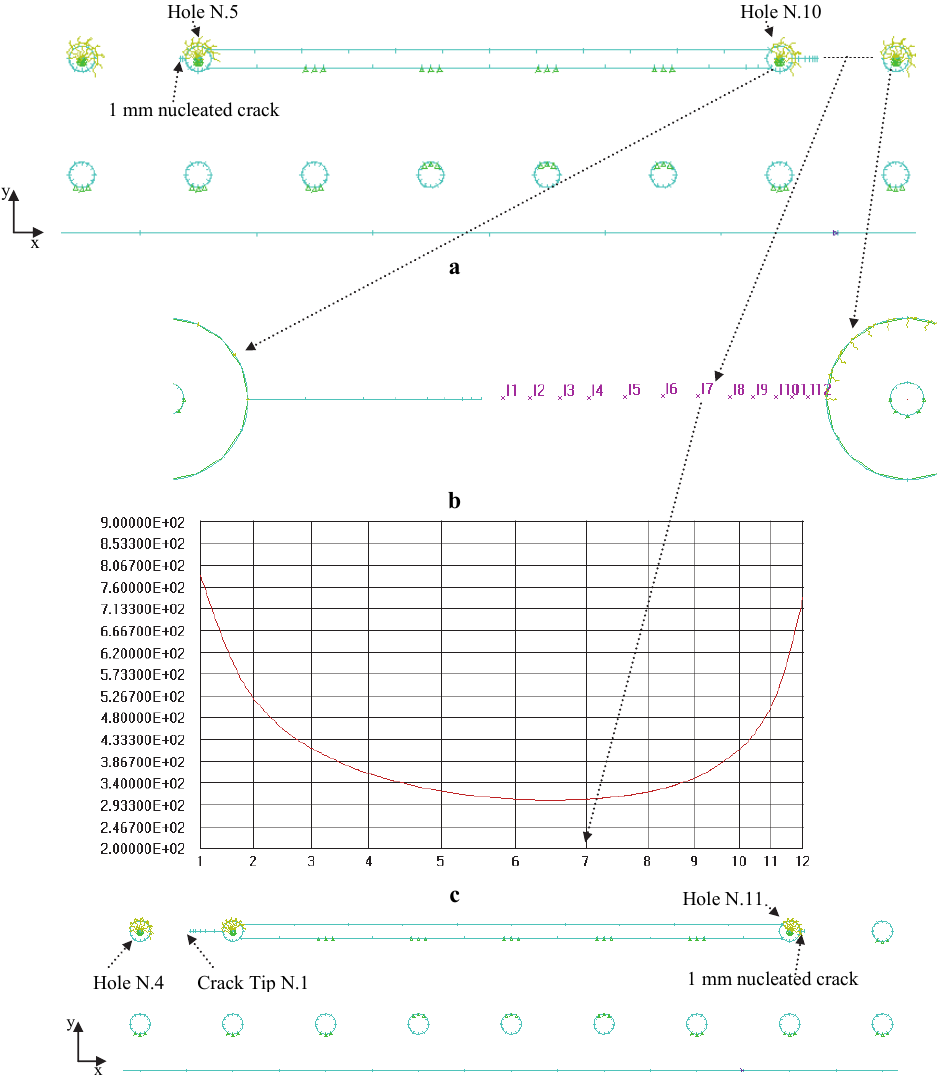
Figure 7a-d: Close up of the main crack after first link-up on the left side of main crack (a); internal point position, in the configuration preceding the second link-up (b) and related Von Mises stresses on the residual ligament of the main crack right side (c); close up of the main crack after second link-up on the right side